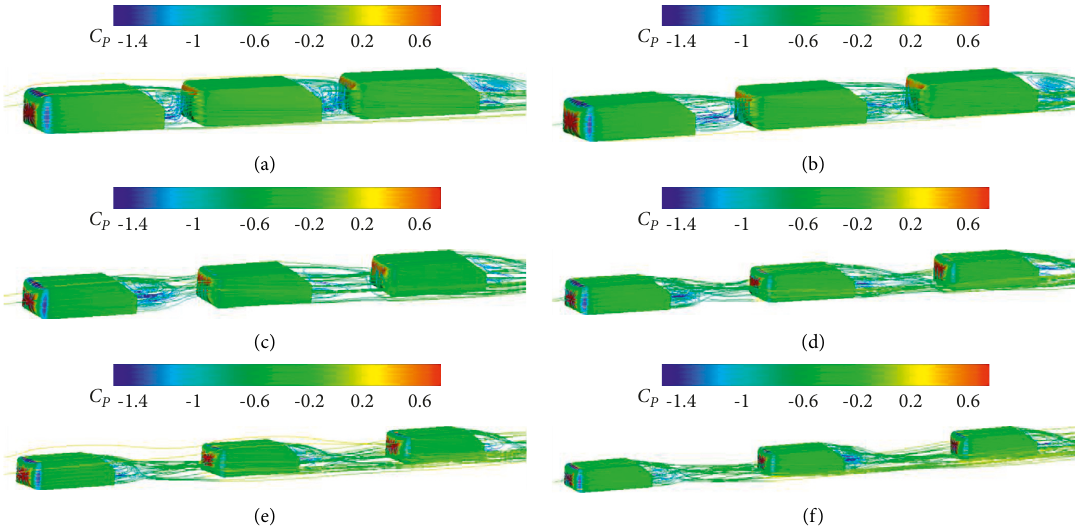
Figure 17: The static pressure and three-dimensional streamlines on the surfaces of three bodies under different inter-vehicle distances, where the three-dimensional streamlines are colored by the x -direction velocity. (a) x/L � 0.25 (b) x/L � 0.5. (c) x/L � 0.75. (d) x/L � 1. (e) x/L � 1.25. (f) x/L � 1.5.